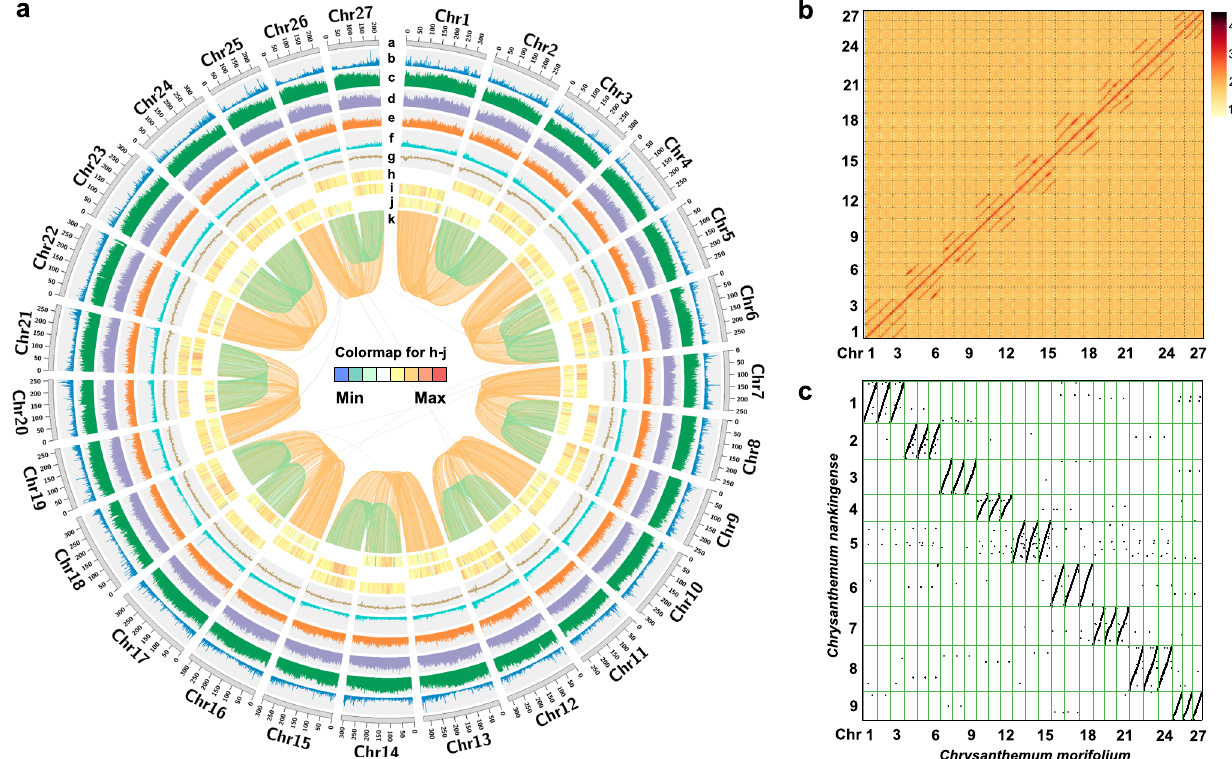
Fig.1|Overviewofthe C.morifolium genome.a Circusplotshowingthegenomic features of the haploid C. morifolium cv. ‘ Zhongshanzigui ’ . Circular tracks from outsideto insideindicate: a thepseudomolecules; b gene density; c density of LTR transposons; d density of Copia transposons; e density of Gypsy transposons; f density of DNA transposons; g GC content; h Ka / Ks of syntenic gene pairs iden- ti fi ed between traid1 and either traid2 or traid3 within a homoeologous chromo- some group; i Ka / Ks of syntenic gene pairs identi fi ed between traid2 and either traid1 or traid3 within a homoeologous chromosome group; j Ka / Ks of syntenic gene pairs identi fi ed between traid3 and either traid1 or traid2 within a